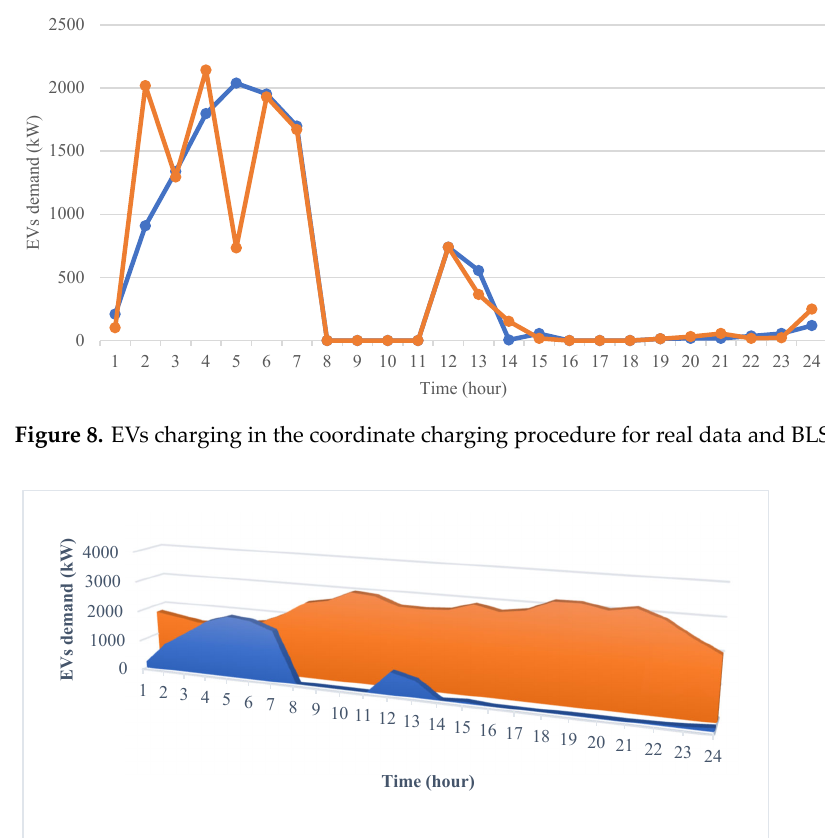
Figure 9. Impact of coordinated charging on the network load.